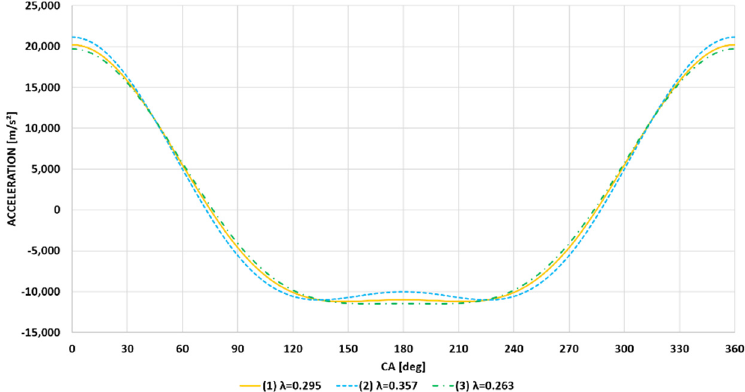
Figure 2. Piston acceleration behavior as a function of the connecting rod ratio.